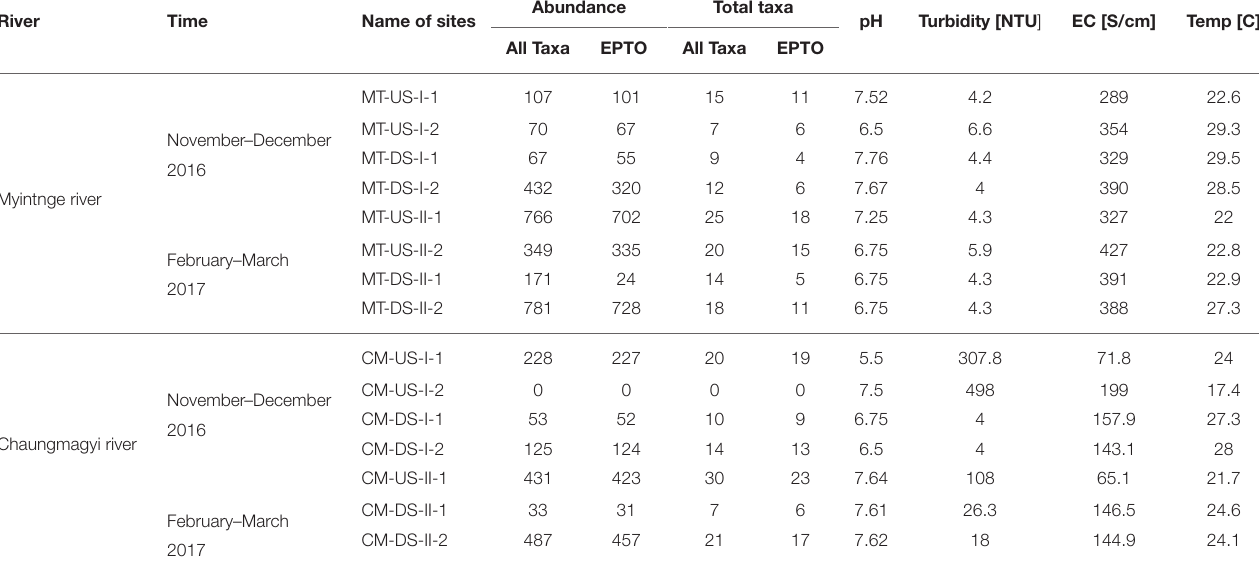
TABLE 2 | Collected abundance and taxa richness of all macroinvertebrates taxa and EPTO with four Physico-chemical water quality parameters at each sampling site in Myitnge and Chaungmagyi Rivers for two sampling periods. River Time Name of sites